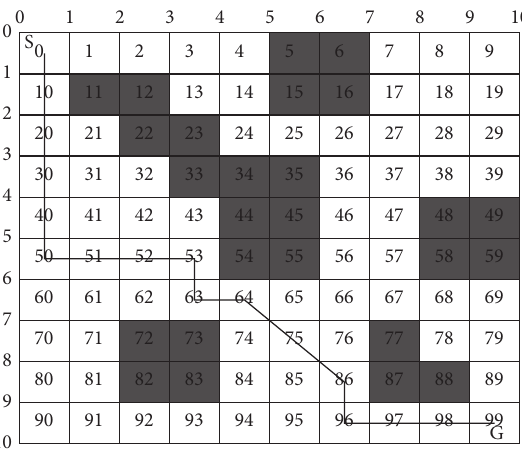
Figure 5: Original path diagram.